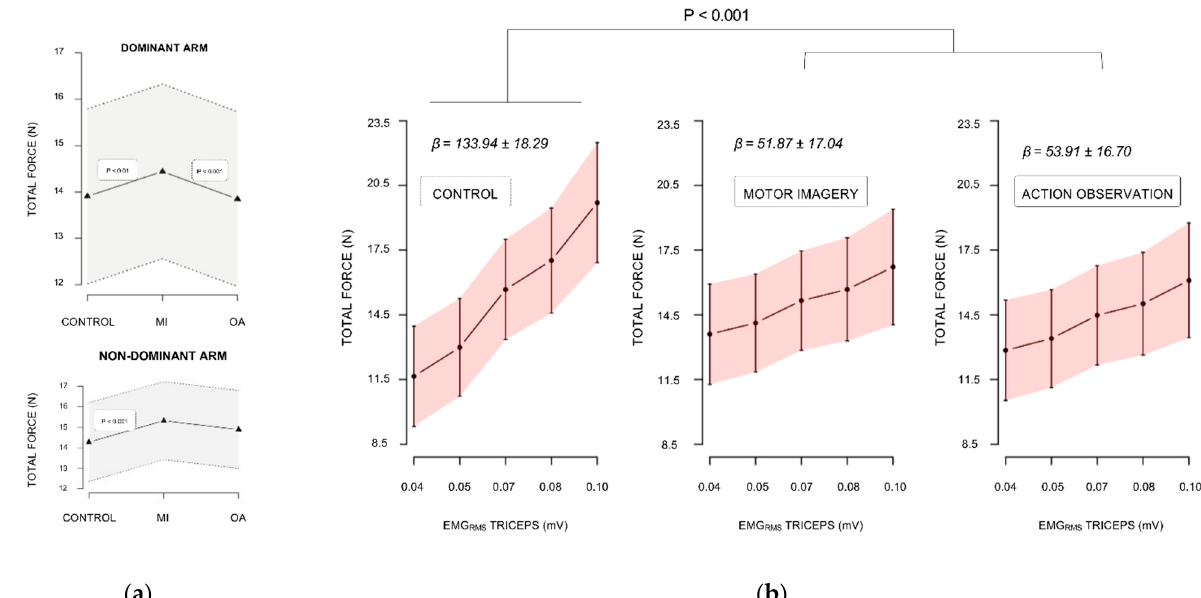
Figure 2. Linear mixed effects analysis of the total force. ( a ) Total force estimates during condition for the dominant (trained) arm and non-dominant (untrained) arms presented with 95% confidence intervals (dotted lines); ( b ) Total force by triceps brachii EMG RMS regression slopes during control, motor imagery, and action observation conditions represented by 95% confidence interval (error bars). MI: motor imagery. AO: action observation.